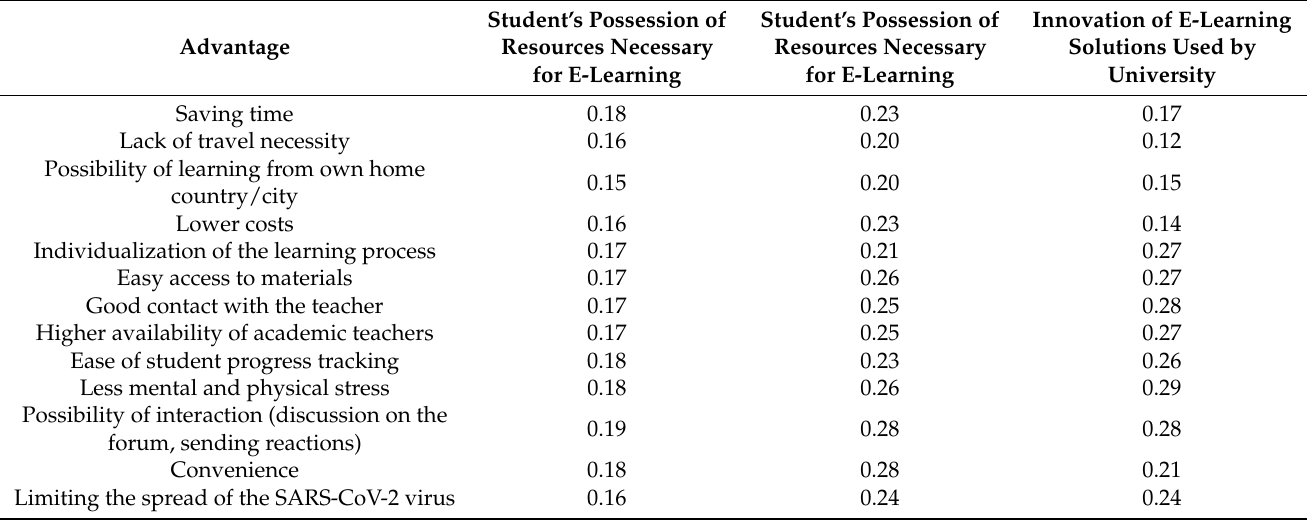
Table 6. Sperman’s rank correlations between the advantages of using e-learning and the student’s knowledge of information technology, the student’s possession of resources necessary for e-learning, and the innovation of e-learning solutions used by university at which the given student studies.